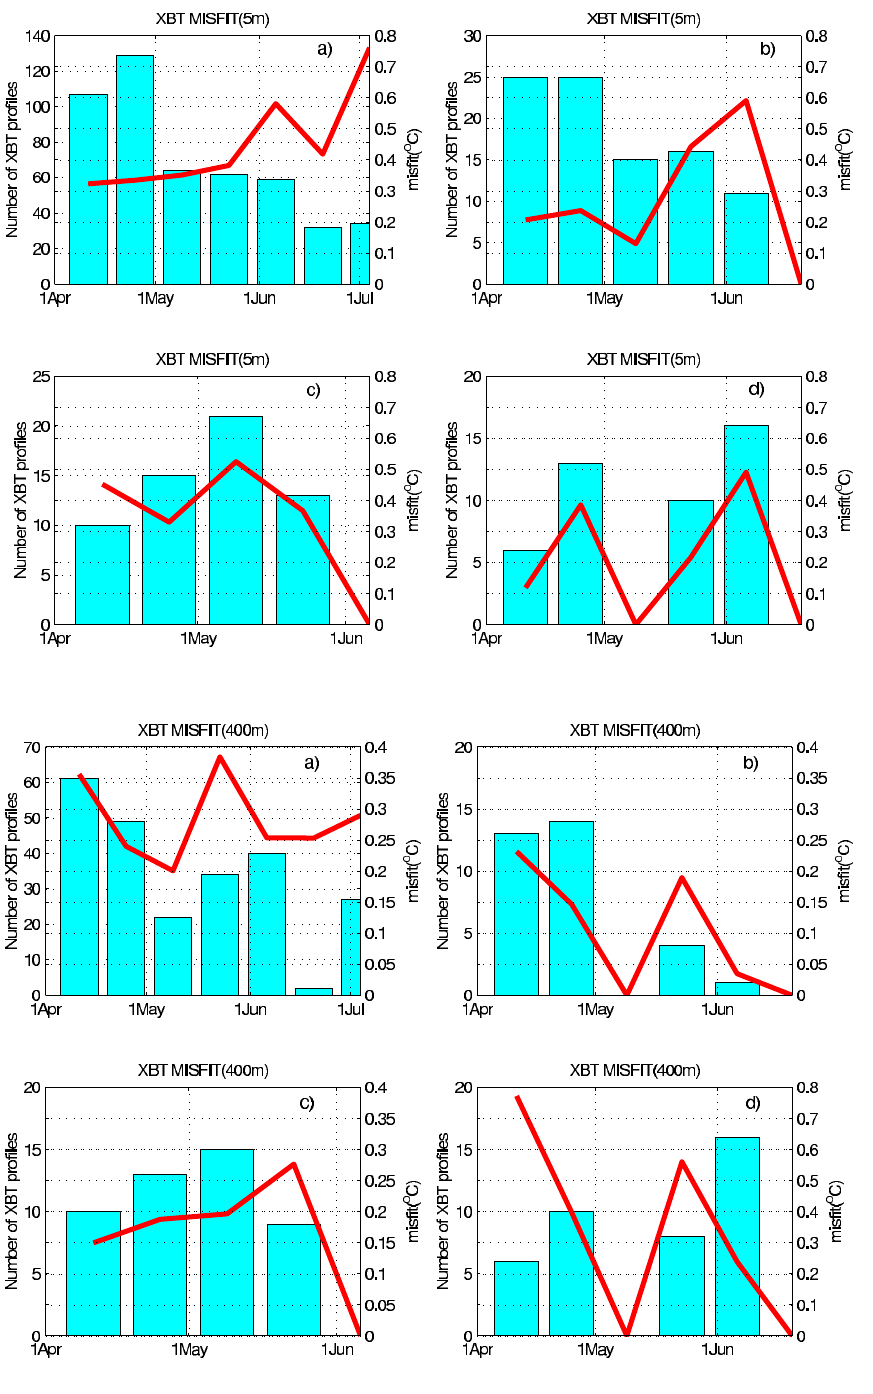
Fig. 15. Normalized root mean square difference between forecast and XBT observations at 400 m depth for (a) whole basin; (b) Algerian Basin; (c) Tyrrhenian Sea; (d) Ionian Sea. The blue bars indicate the number of XBT profiles available during every bi- weekly analysis